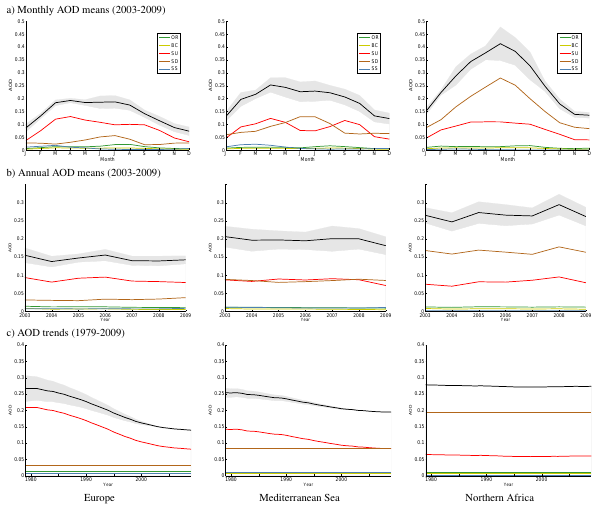
Fig. 18. Standard deviation of total AOD at 550nm (top) and Angstrom exponent (AQUA/MODIS, bottom) over the Mediter- ranean region for the 2003-2009 period. No means has been found to evaluate properly the sepa- ration between the different aerosol types. Previous studies 1300